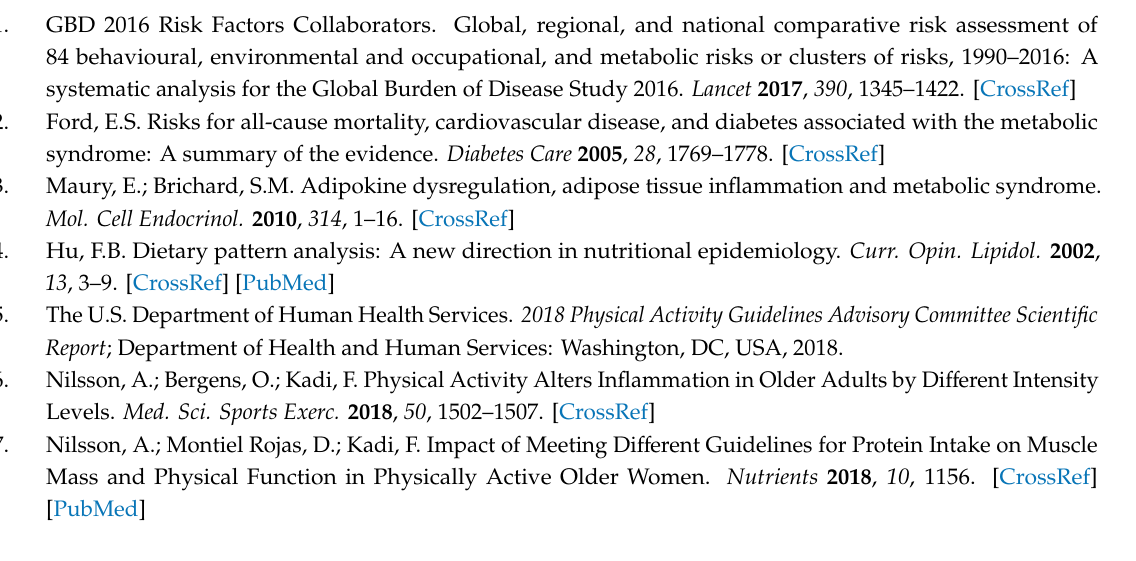
Table S1. Daily intake of DASH-related food groups in the study